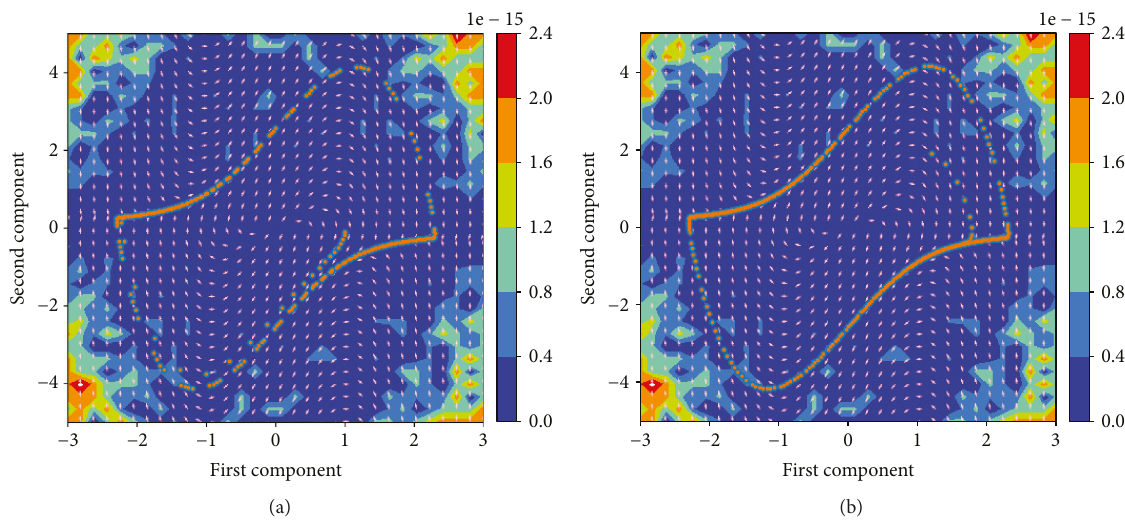
Figure 6: Stepwise error contour of SINDy on VDP case. (a) Training data. (b) Testing data. Blue dot: ground truth. Orange dot: prediction. White arrow: direction of target vector of ground truth. Red arrow: direction of target vector of prediction.